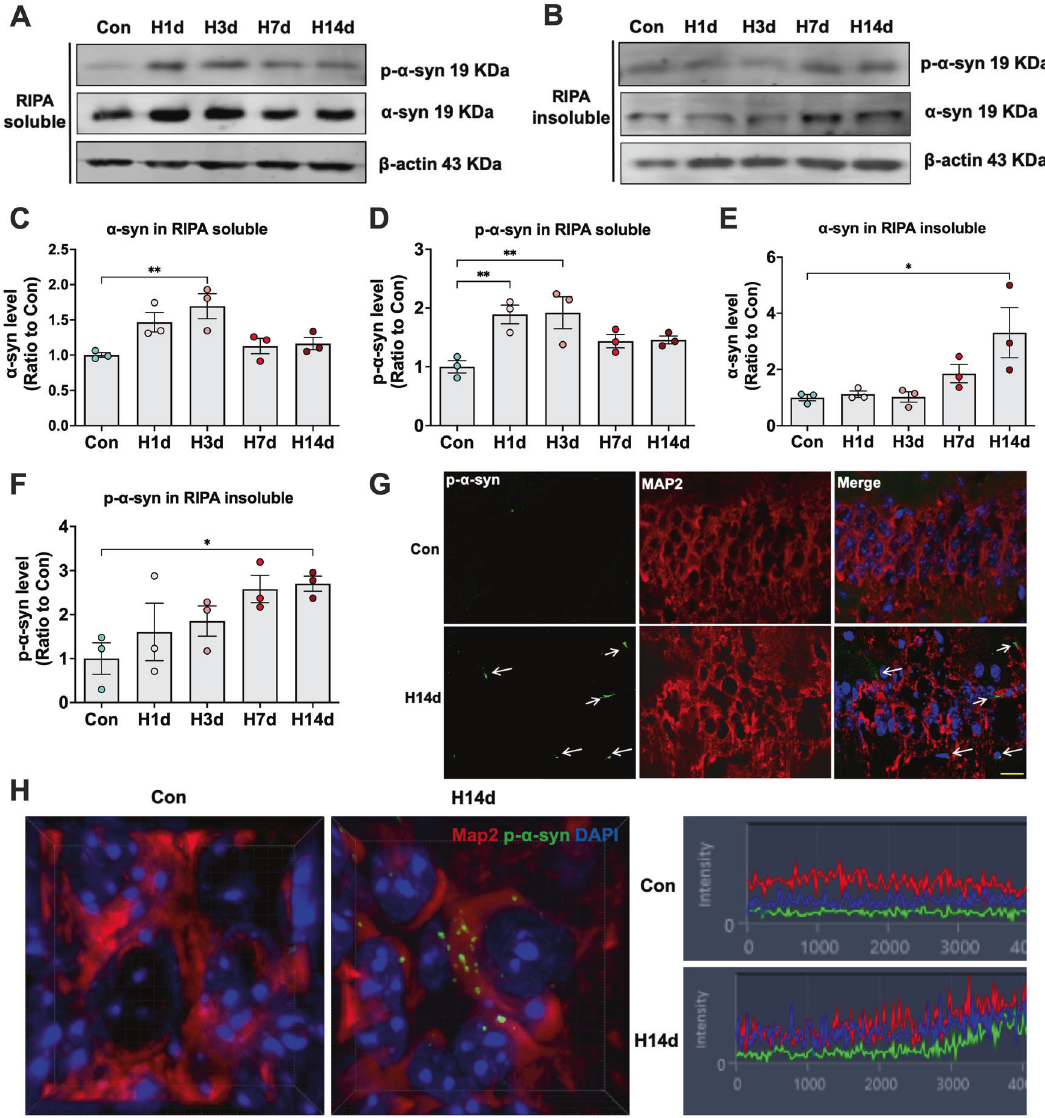
Fig. 2 Chronic hypoxia promotes α -syn phosphorylation at ser129 and abnormal aggregation in the mouse hippocampus. A – F The levels of p- α -syn and α -syn in the RIPA-soluble and RIPA-insoluble fractions (8 M urea dissolved) from the hippocampi of mice in each group (Con, H1d, H3d, H7d, H14d) were detected by western blots with β -actin as the internal reference; Statistical analysis was performed. G The levels of p- α -syn and the neuronal marker Map2 in the hippocampus of the H14d group and Con group were detected by immuno fl uorescence. H The high-power three-dimensional imaging of p- α -syn immuno fl uorescence and the fl uorescence intensity of each channel. Data are expressed as the mean ± SEM (one-way ANOVA). * P < 0.05, ** P < 0.01, n = 3. Bar = 50 μ m in G